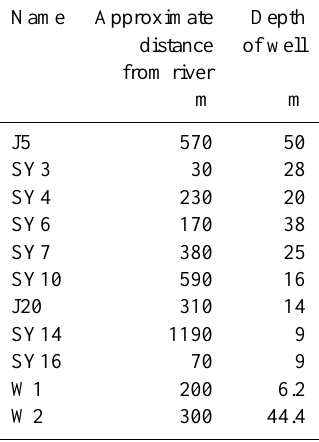
Table 1. The information of groundwater